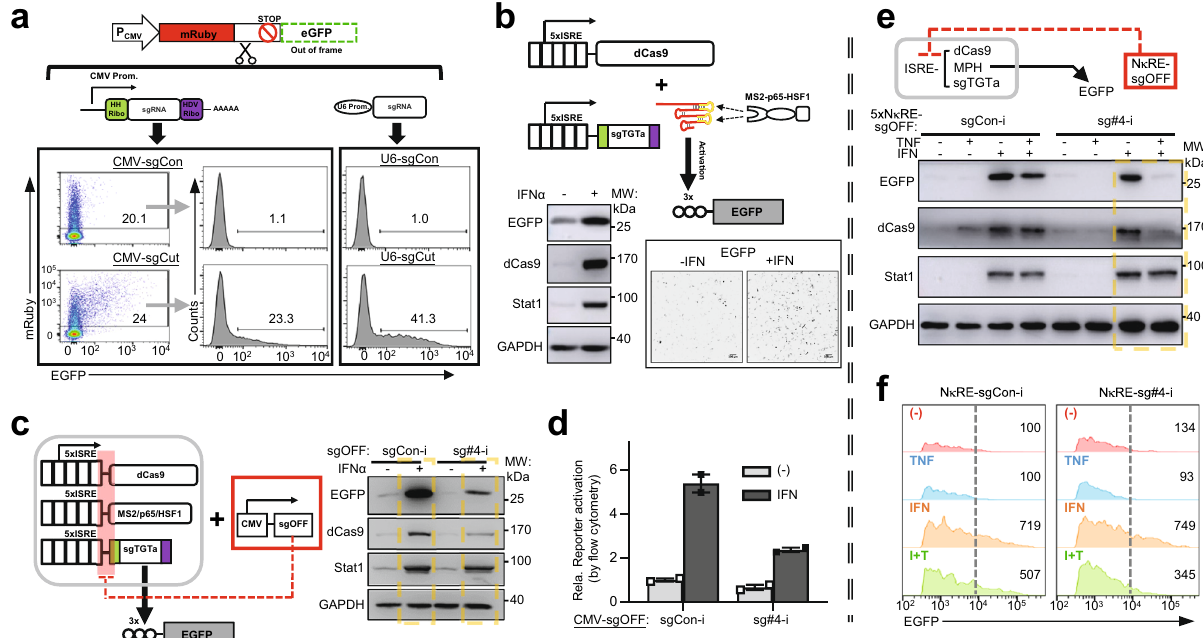
Fig. 2 Construction of a preliminary dual-input, AND – NOT logic circuit. a An EGFP reporter whose expression as a fusion protein would be initiated by Cas9/sgRNA-mediated upstream cleavage (frameshift) is illustrated on top. A ribozyme-based, Pol II sgRNA expression system is illustrated right below. 293T cells were transfected with Cas9 and the reporter, as well as the CMV-driven sgRNA for cutting the reporter construct (sgCUT), its Pol III counterpart, or the corresponding control non-targeting sgRNAs (sgCon). Cells were harvested (48 h) and subjected to fl ow cytometry. Percentages of EGFP + cells(mRuby + gate) were marked on the histograms. b The illustration on the top shows a Pol II promoter-controlled CRISPRa SAM complex. The dCas9 and targeting sgRNA for activation (sgTGTa) are both led by 5× ISRE, while the co-activator MPH is constitutively expressed. In the reporter, 3× target sites proceed a minimal promoter-led EGFP . After plasmid transfections, 293T cells were treated with human IFN α (1000 IU/ml) for 24 h. EGFP levels were determined by fl uorescence microscopy (inset, scale: 100 μ m), and by immunoblotting (IB, lower left). c , d In c , the illustration shows a circuit with one Pol II promoter (5× ISREs) controlling all three CRISPRa components (activating an EGFP reporter) and another (CMV) driving an off-switching sgRNA (sgOFF, targeting all three CRISPRa components). A non-targeting sgRNA (sgCon-i) serves as a control for the sgOFF. Transfected cells were treated (1000 IU/ml IFN, 48 h) and harvested for IB. In d , some cells were subjected to fl ow cytometry and followed by quantitation (EGFP + %×MFI, mean ± range, n = 2 from independent experiments). e , f The circuit was similar to ( c ), except that the sgOFF was led by 5× N κ RE. The cells were treated ±IFN (1000 IU/ml) and ±TNF (50 ng/ml) for 48 h and harvested either for IB analyses ( e ), or for fl ow cytometry ( f ). In f , the histogram shows the fl uorescence pattern for EGFP + cells. The dotted lines mark high levels of EGFP positivity de fi nitively attributed to CRISPRa activity. Relative levels of EGFP + %×MFI are marked on the histogram. The IB results in b , c , e are representative of two independent experiments. Source data are provided in the Source Data fi